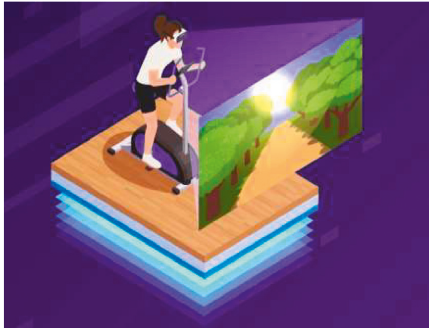
Figure 8: Depiction of workout experience using Metaverse [35].